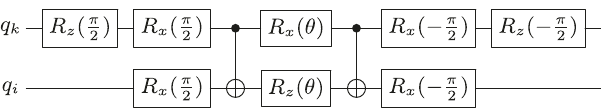
Fig. 1 A circuit to implement a single-qubit-excitation evolution. A single- qubit-excitation evolution is de fi ned by the unitary operator (cid:14) ~ A , where X and Y are the Pauli x and y operators (the subscript denotes the qubit on which these operators act). q i denote the state of qubit i . R x ( θ ) and R z ( θ ) denote single-qubit rotation gates around the x and z axes, respectively, by θ